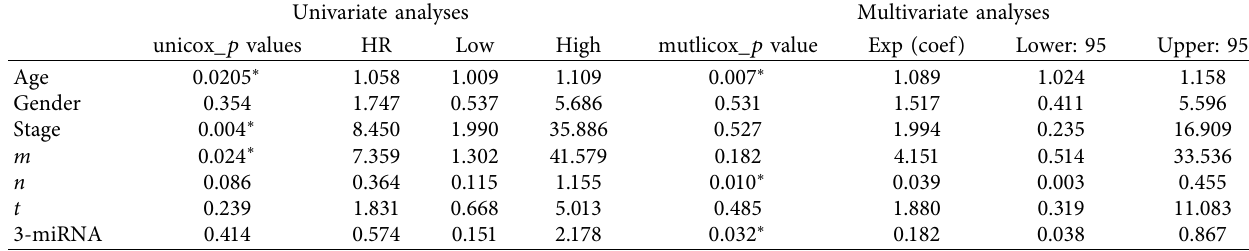
Table 2: Univariate and multivariate cox regression of clinical characteristics associated with overall survival in TCGA dataset. Univariate analyses Multivariate analyses